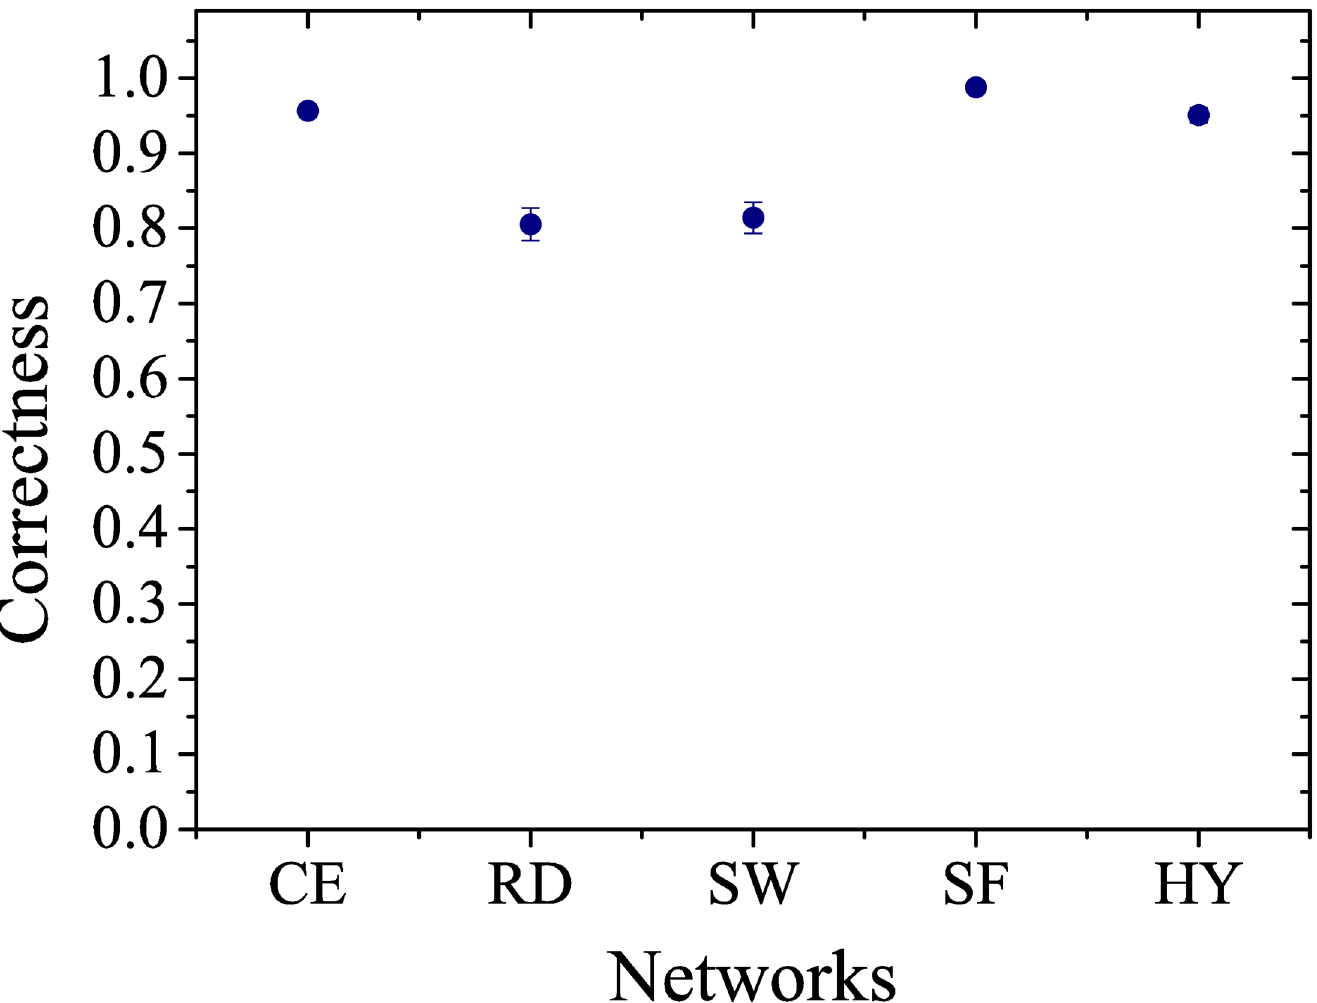
Fig 4. The correctness. (CE) C. elegans , (RD) random, (SW) small-world, (SF) scale-free and (HY) hybrid networks, when attempting to learn to interpret 100 input signals. Mean of 100